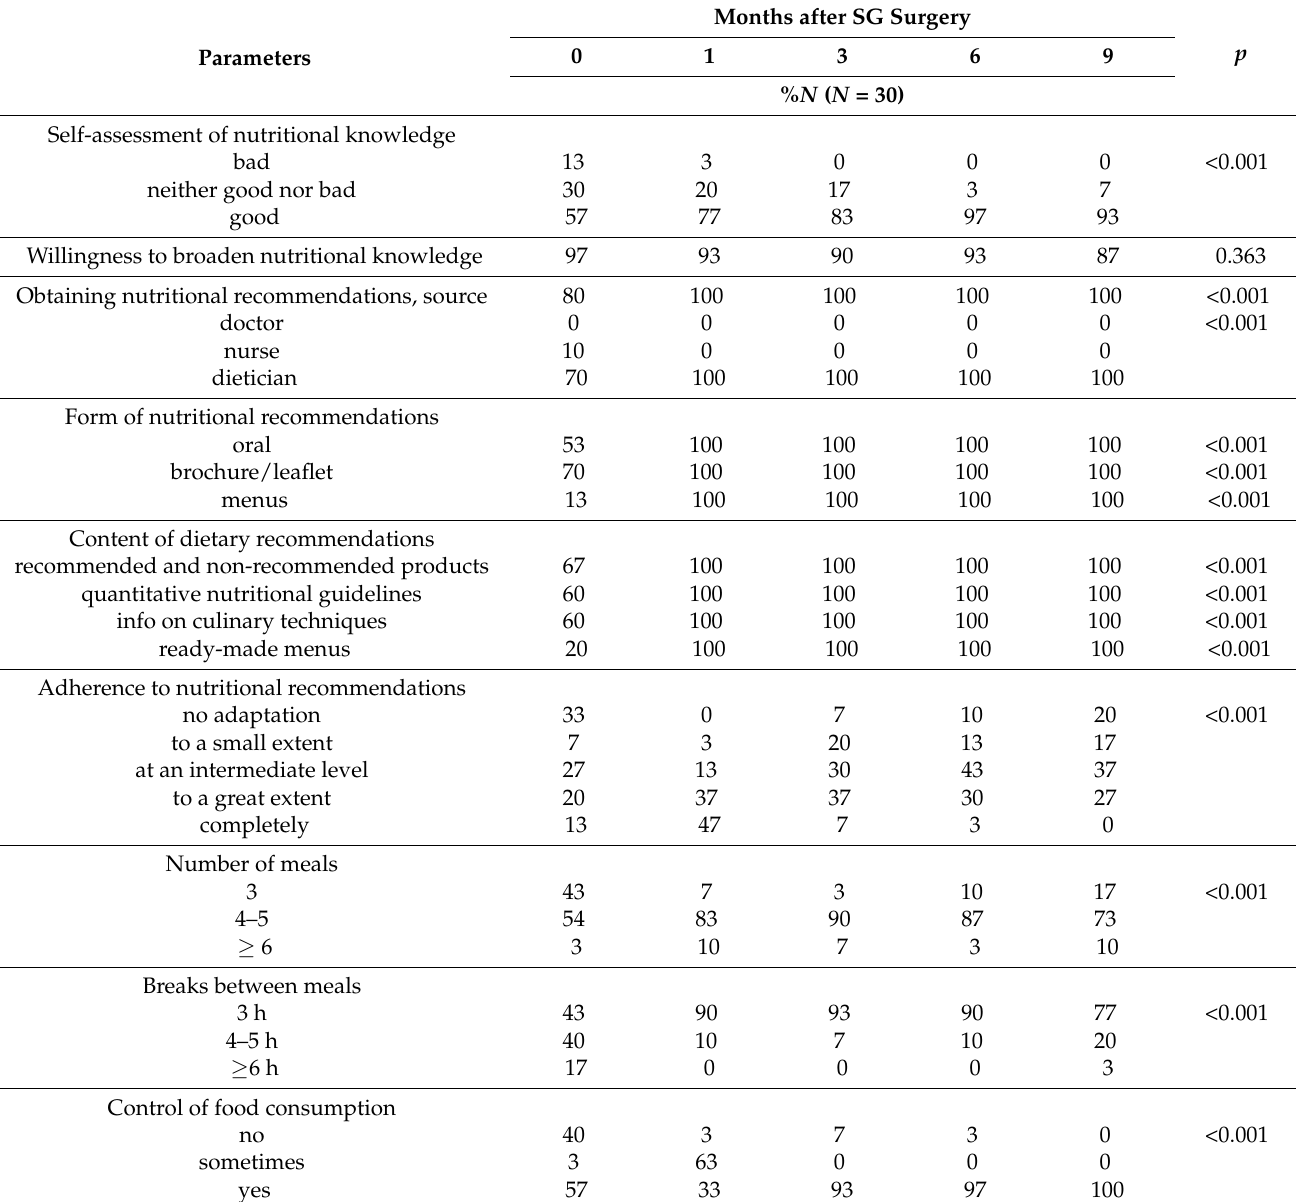
Table 2. Self-assessment of nutritional knowledge, providing and following nutritional recommenda- tions, body weight control and active leisure time in patients within 9 months of